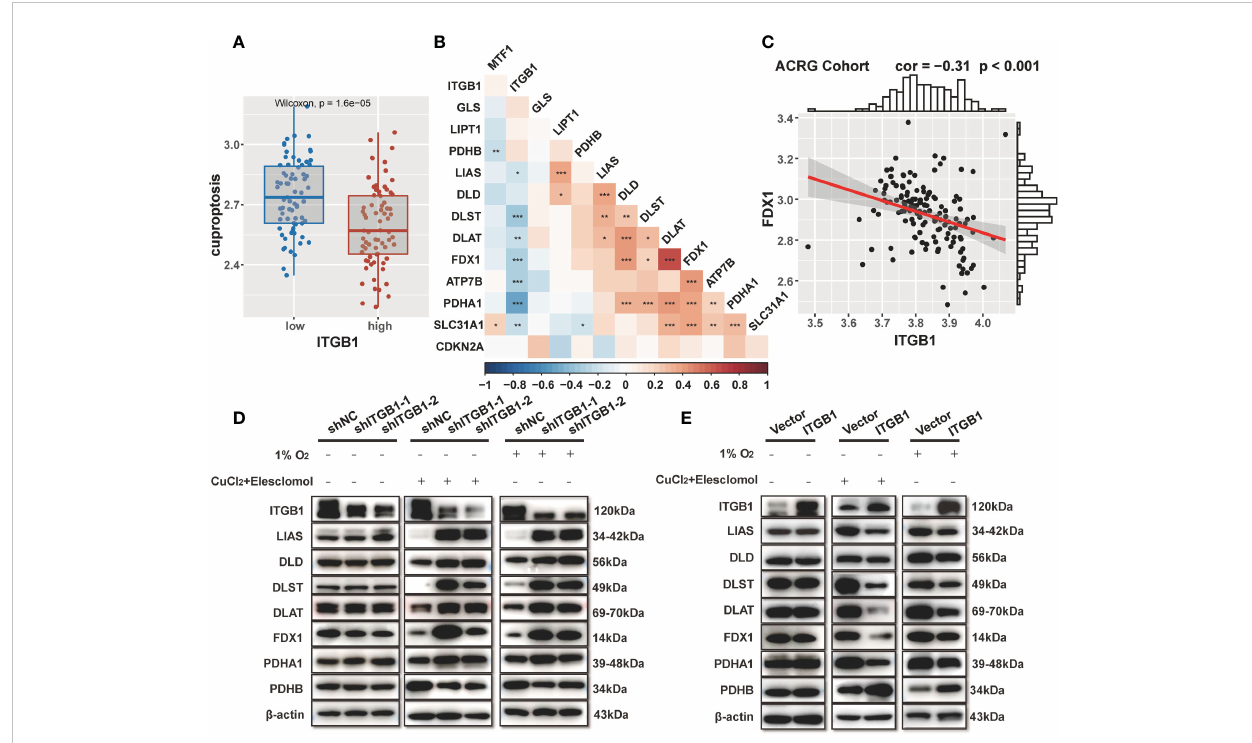
FIGURE 6 Association of ITGB1 with cuproptosis in DGC (A) Cuproptosis was strati fi ed by ITGB1. (B) Correlations between ITGB1 and the cuproptosis-related- gene using Spearman analysis. The negative correlation was marked with blue and positive correlation with red. (C) Correlation analysis between ITGB1 and FDX1 in ACRG cohort. (D) Western blotting analysis of ITGB1, LIAS, DLD, DLST, DLAT, FDX1, PDHA1, PDHB and b -actin in MKN-45 cells with or without knockdown. (E) Western blotting analysis of ITGB1, LIAS, DLD, DLST, DLAT, FDX1, PDHA1, PDHB and b -actin in MKN-45 cells with or without overexpression. *, P<0.05; **, P<0.01; ***,